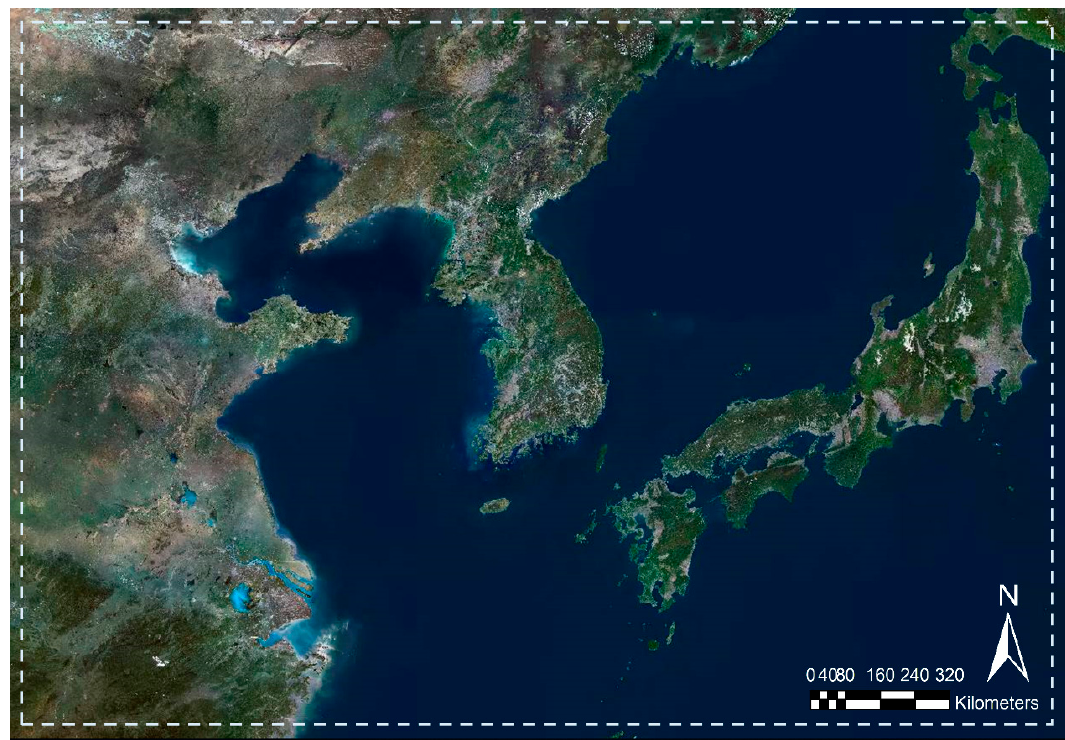
Figure 2. High resolution climate change scenario area on the Korea Peninsula. Table 1. Information of future climate data. (GCMs: Global Climate Models; RCP: Representative